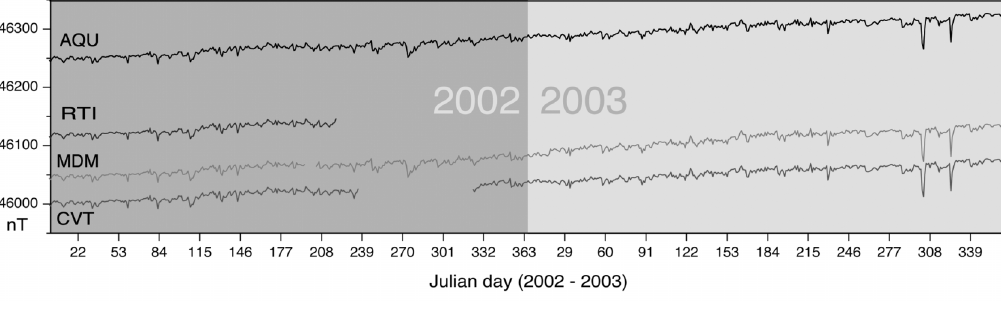
Fig. 3. Enlargement of time variations of total magnetic field F (daily averages) at L’Aquila (AQU) and at tectonomagnetic stations (CVT, MDM, RTI) for the years 2002 and 2003.